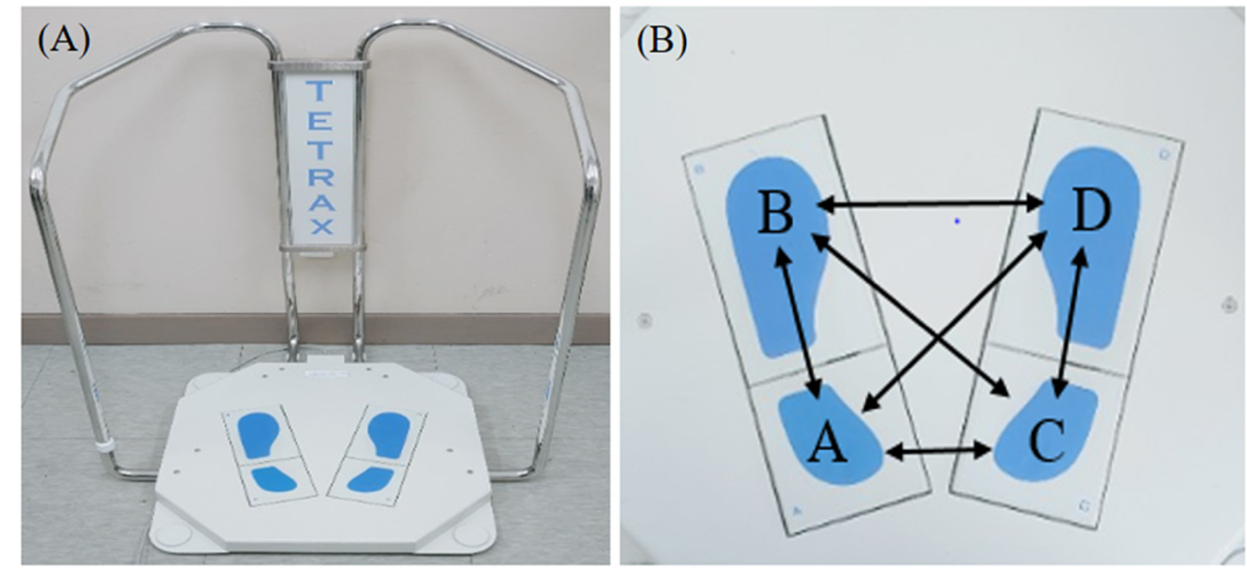
Figure 1. TETRAX postural balance device ( A ) and schematic diagram of six synchronizations on four plates ( B ).